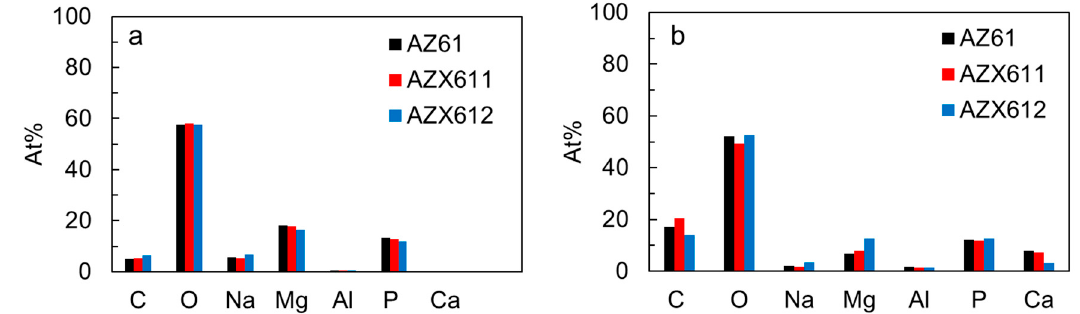
Figure 11. Atomic fraction of elements detected by EDS analysis on PEO coatings of AZ61, AZX611, and AZX612 specimens ( a ) before and ( b ) after 14 days immersion in SBF.